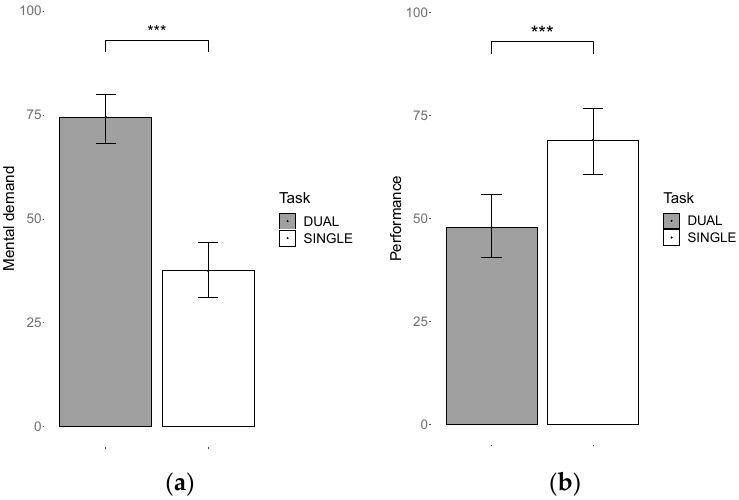
Figure 11. ( a ) Mean perceived mental demand and ( b ) perceived performance as a function of task di ffi culty. *** p < 0.001.